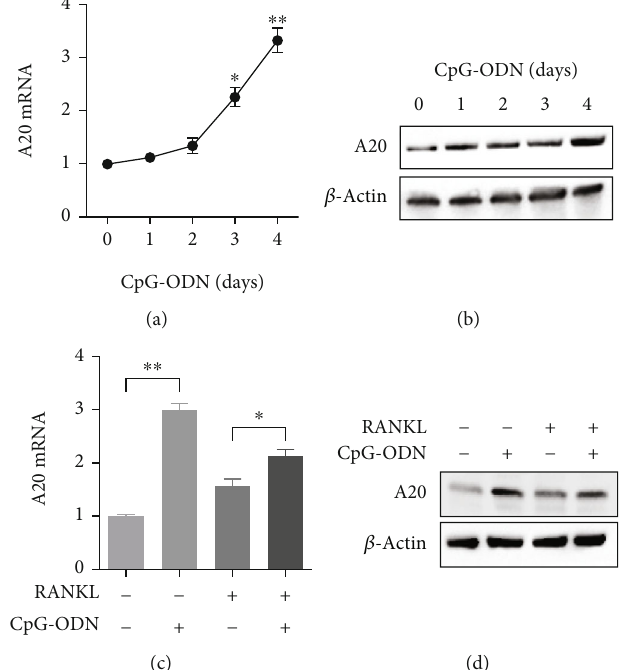
Figure 2: CpG-ODN induced A20 deubiquitinase. (a, b) A20 mRNA and protein expression were measured in RAW 264.7 cells incubated with CpG-ODN (1 μ M) for 0 to 4 days. (c, d) A20 mRNA expression in RAW 264.7 cells stimulated with either RANKL (100ng/ml) or CpG-ODN (1 μ M) and both. Error bars represent standard deviation of the measurement of three separate samples ( ∗ p < 0 : 05 and ∗∗ p < 0 : 001